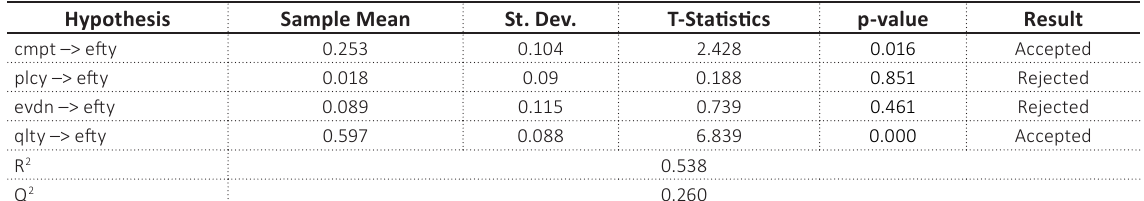
Table 4. Regression results